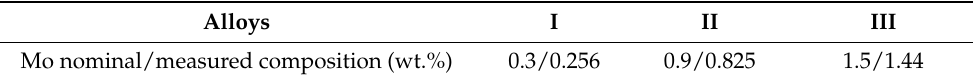
Table 1. Chemical compositions of the experimental alloys. Alloys I II III Mo nominal/measured composition